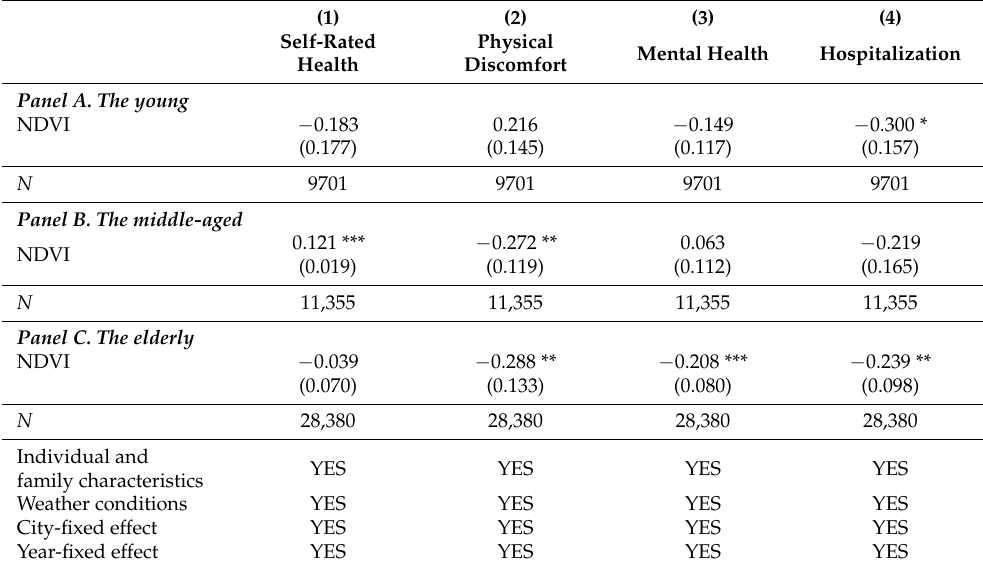
Table 4. Heterogeneous effect of greenspaces by age.